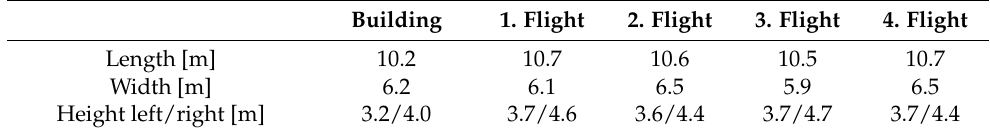
Table 5. Comparison of the winery dimensions and the transformed radar data. Building